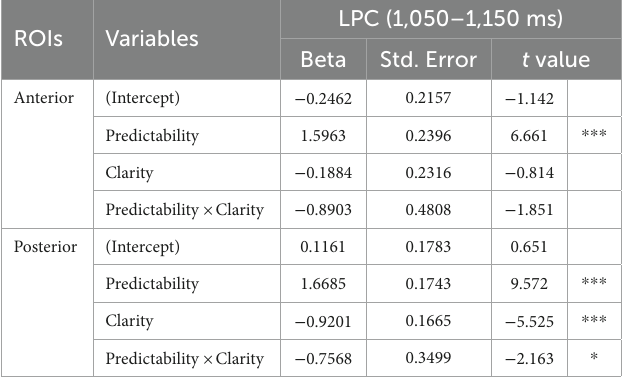
TABLE 3 LMM estimates of fixed effects for the predictability and clarity effects on the